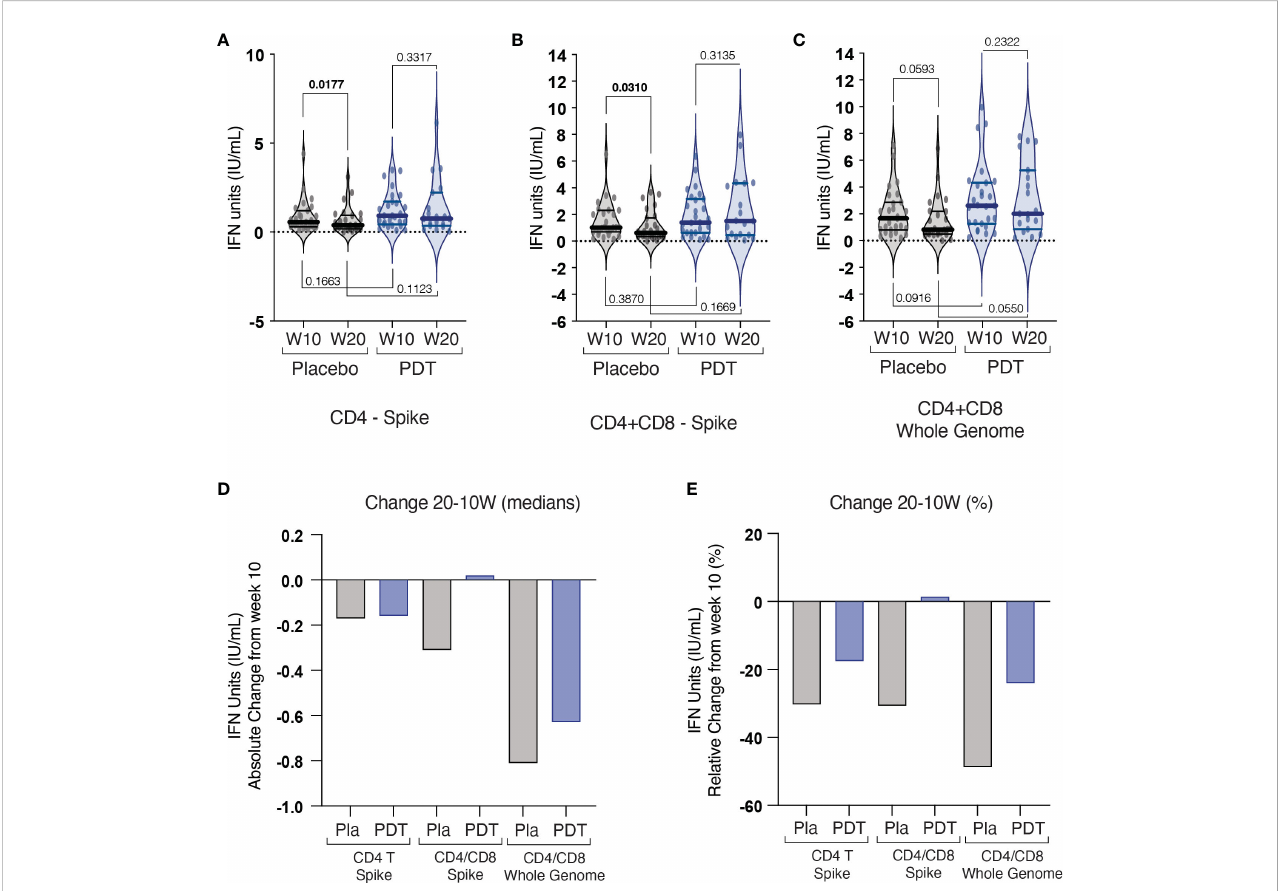
FIGURE 4 Results of cellular immunity assays. Quantiferon assay was used to analyse the speci fi c T-cell responses against speci fi c puri fi ed peptides from the spike antigen (S1, S2, RBD subdomains) either using isolated CD4 (A) or a combination of CD4/CD8 (B) T cells from placebo and PDT-treated subjects, or against additional speci fi c peptides from the full genome of SARS-CoV-2 (S, N and M domains) testing both CD4 and CD8 responses (C) . (D) Change of median values of IFN units at 20 weeks when compared to 10 weeks for the three assays. (E) Percentage of change of median IFN units at 20 weeks when compared to 10 weeks. Pla, Placebo; PDT, Photodynamic Therapy; W, Week; IFN, Interferon